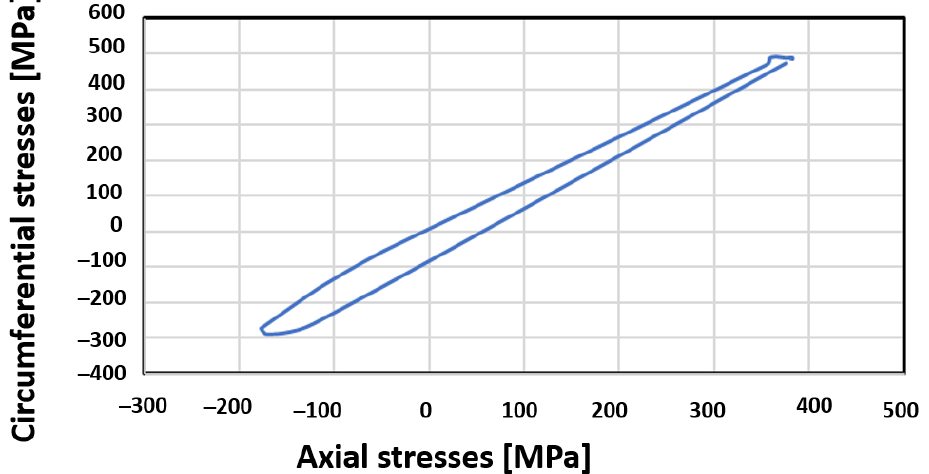
Figure 18. Tangential stress vs. axial stress [MPa].